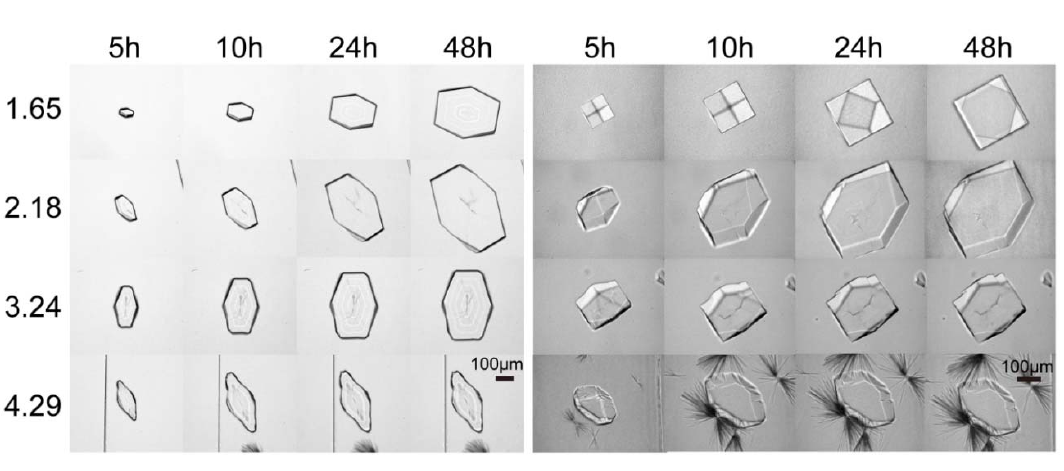
Figure 4. The morphology evolutions of the crystals grown in the microchannel with the increasing initial supersaturation.